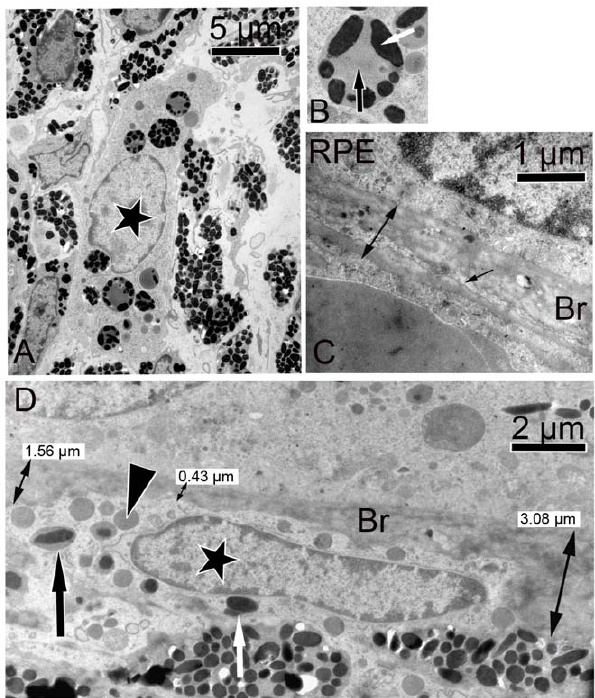
Figure 4. TEM micrographs of ZD-LE eyes. A) a macrophage in the choroid (black asterisk, also seen in figs. 5B and 6D) contains melanosomes. B ) a higher magnification of the cell seen in (A) bearing lysosomes containing homogenous material (black arrow) and mela- nosomes (white arrow). C ) Bruch’s membrane (Br) delimitated on one side by the basal labyrinth of the RPE and on the other side by a capillary (double arrow). The arrow shows an infiltrated cell inside the Bruch’s membrane. The five layers of the Bruch’s membrane are no more identifiable. D ) Choroid-RPE interface showing a thin macrophage just below the Bruch’s membrane (black asterisk in the nucleus, also seen in fig. 6D) which contains lipofuscin- (black arrowhead), melanin- (white arrow) and melanolipofuscin-like (black arrow) granules. Note the varying thickness (0.4–3 m m) of the Bruch’s membrane (Br) and the increase of the extracellular matrix in Bruch’s membrane on both sides